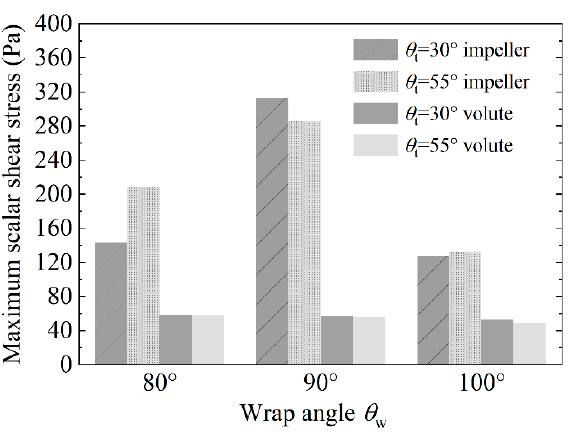
Figure 10. Maximum scalar shear stress (SSS) around the impeller area of six test pumps at the orig- inal design point by CFD simulation ( Q 0 = 5.0 L/min, n = 2500 r/min). original design point by CFD simulation ( Q 0 = 5.0 L/min, n = 2500